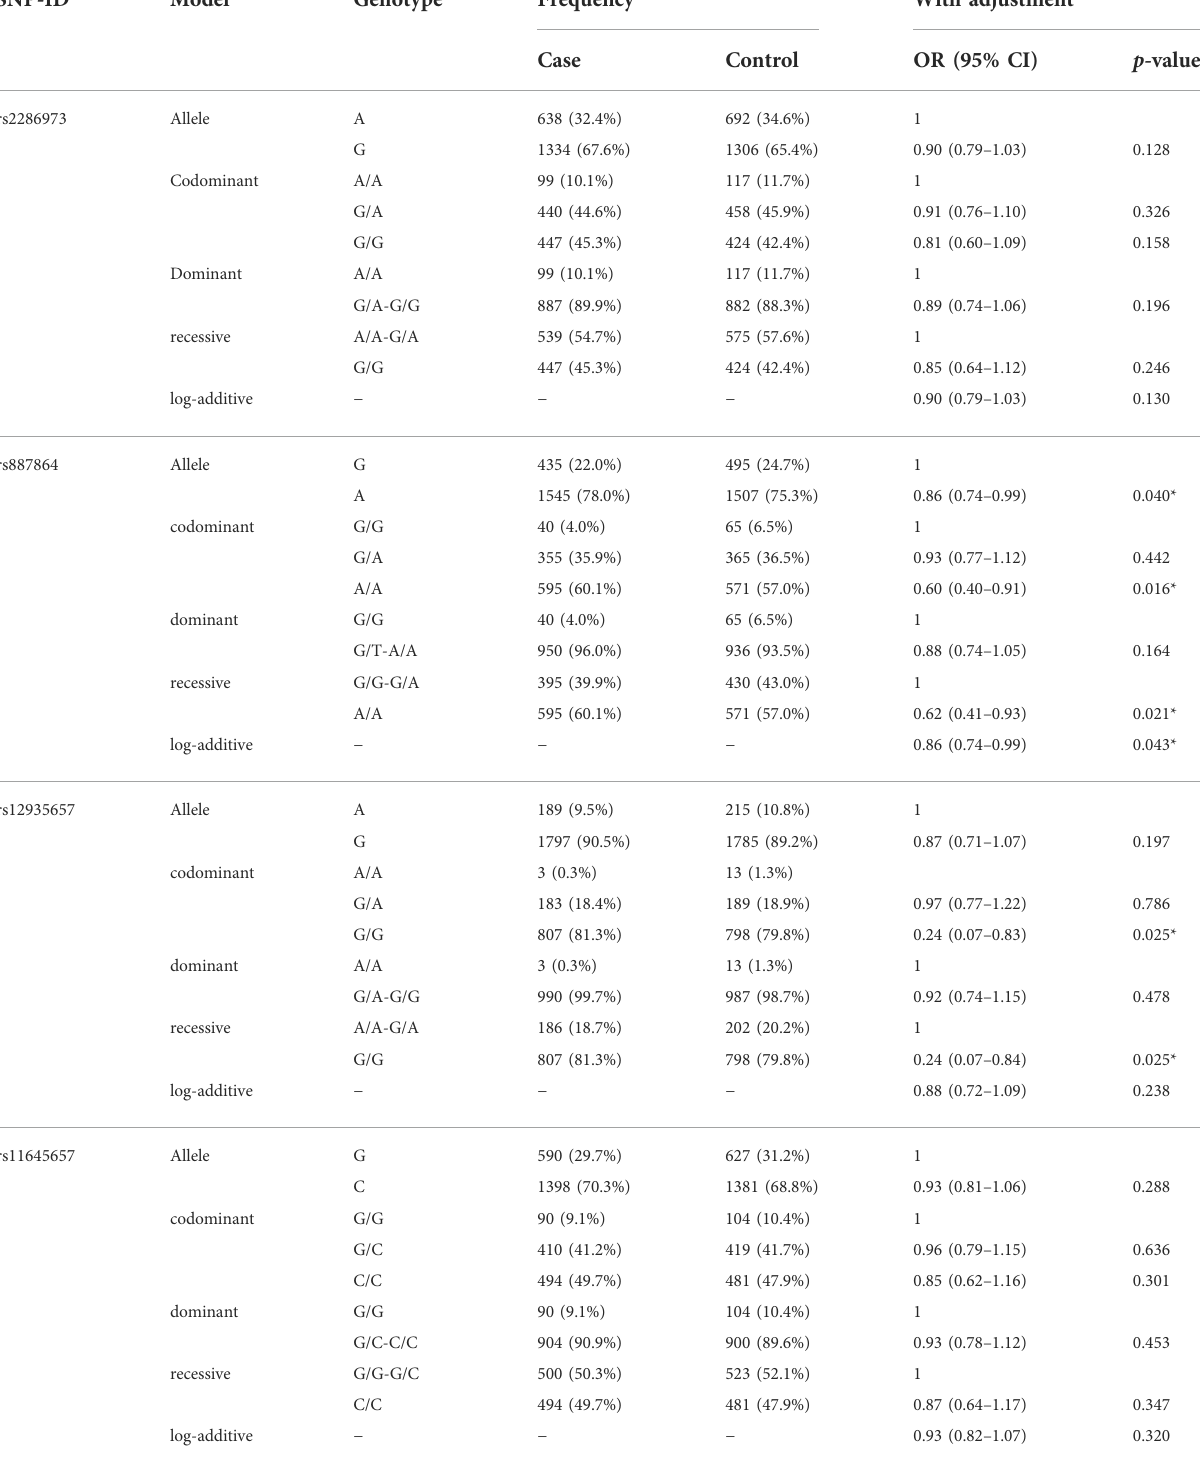
TABLE 3 Association between CLEC16A variants and AR risk in the total